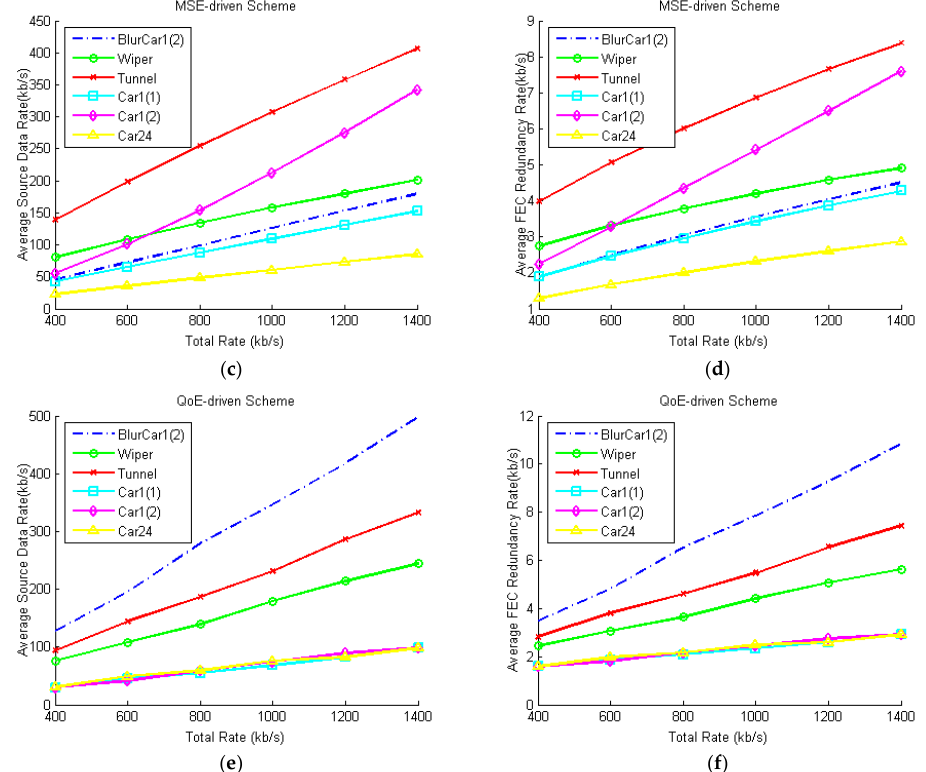
Figure 14. Average source data rates and FEC redundancy rates of each video under different total rate constraints. The packet loss rate of each video is 1%: ( a ) Average source data rates of proposed scheme; ( b ) Average FEC redundancy rates of proposed scheme; ( c ) Average source data rates of MSE-driven scheme; ( d ) Average FEC redundancy rates of MSE-driven scheme; ( e ) Average source data rates of QoE-driven scheme; ( f ) Average FEC redundancy rates of QoE-driven scheme.